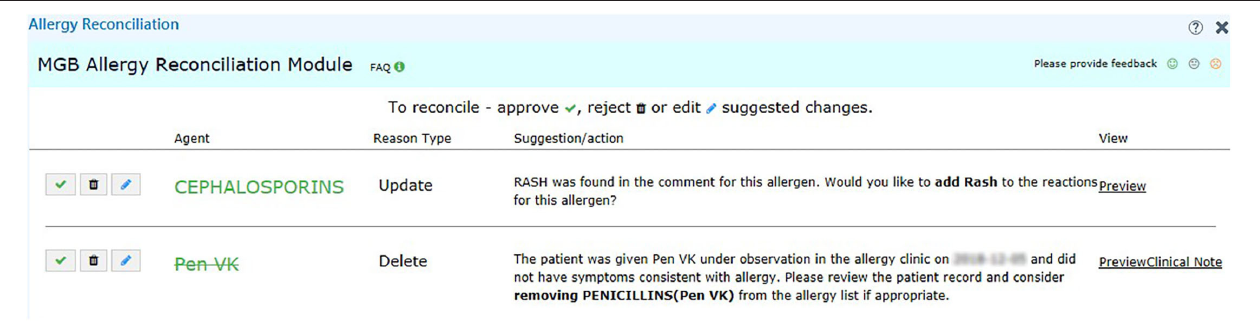
FIGURE 4 | User interface of the recommendation for challenge tests. We provide the reason in addition to the suggested action, such as “Add” and “Delete” for the user to make decision. We also include a hyperlink (right-hand side) to the clinical notes in case the user wants to know more about the reaction.